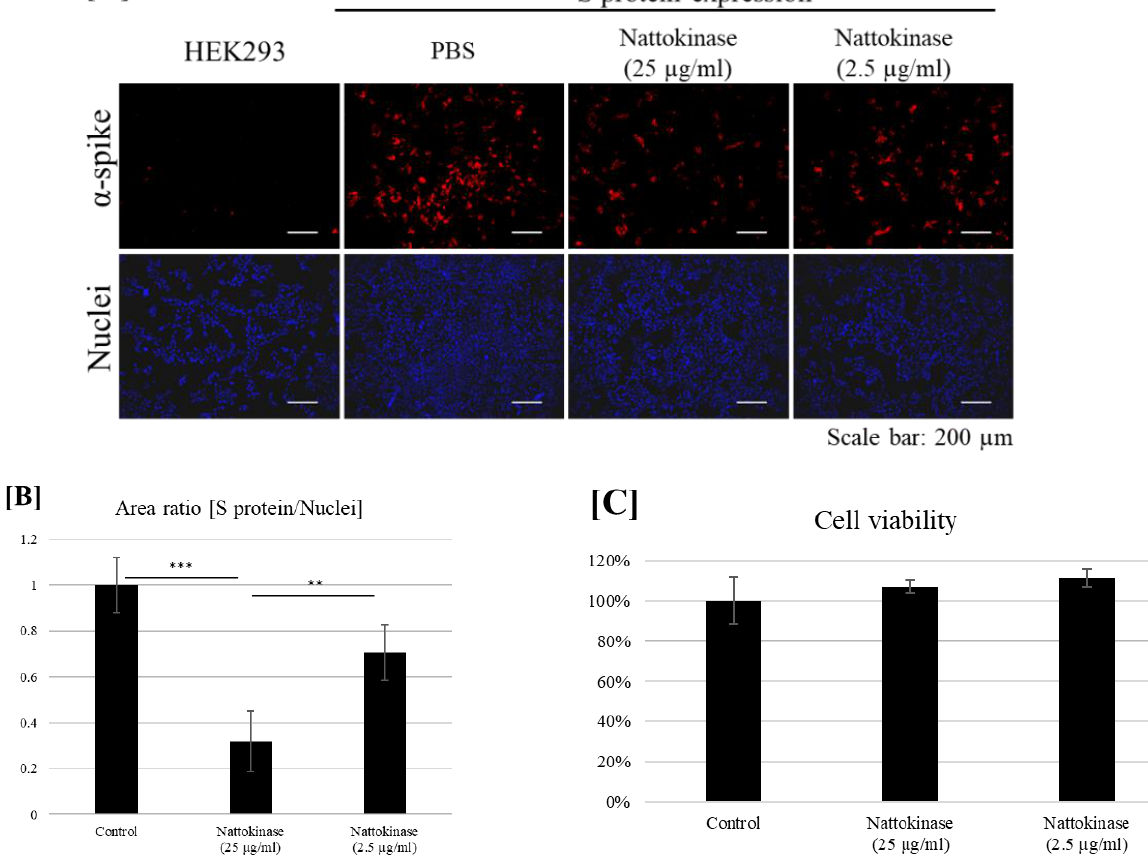
Figure 2. ( A ) Degradative effect of nattokinase on S protein on the cell surface. Spike-pcDNA3.1 was transfected with HEK293 cells and incubated for 9 h. After incubation, nattokinase (25 and 2.5 µg /mL) were added to culture medium and further incubated for 13 h. Cells were fixed and immunofluorescent analysis was performed. S protein on the cell surface was stained with anti-spike protein antibody (Red) and nucleus was stained with DAPI (Blue). ( B ) Ratio of S protein area to nucleus positive area. Three images per sample were captured and S protein/nucleus positive areas were calculated. Data are shown as mean + SD, and p -value was determined by one-way analysis of variance (ANOVA) with Tukey ’ s post-hoc test using R software (R- 3 .3.3 for windows) (** p < 0.01; *** p < 0.001). ( C ) Cell viability was evaluated by MTT assay. Indicated nattokinase was added to culture medium and incubated for 13 h; MTT assay was performed.